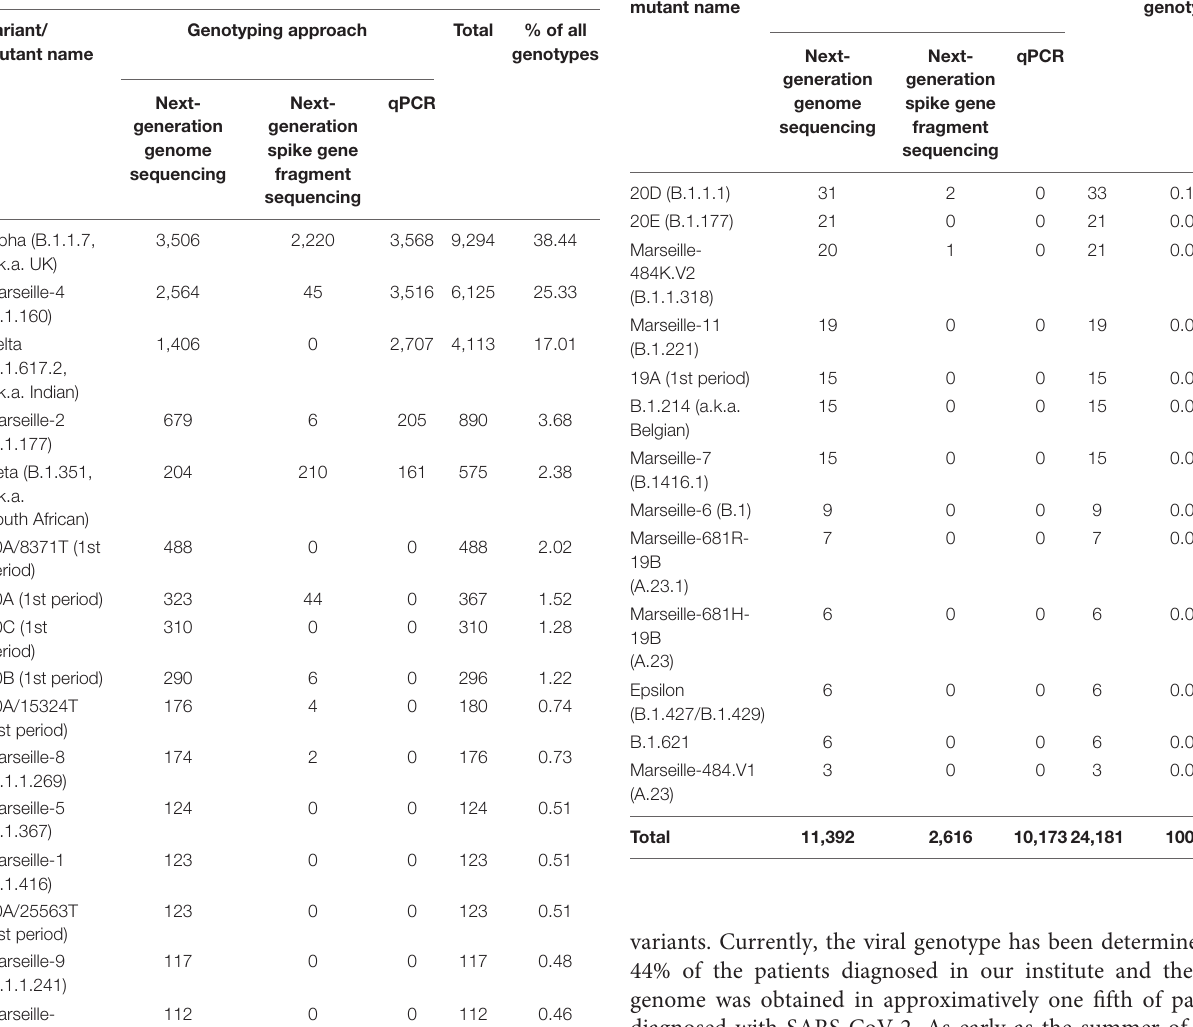
TABLE 2 | Numbers of the main SARS-CoV-2 variants and mutants diagnosed among the IHU Méditerranée Infection cohort of SARS-CoV-2-infected patients as of 18 August